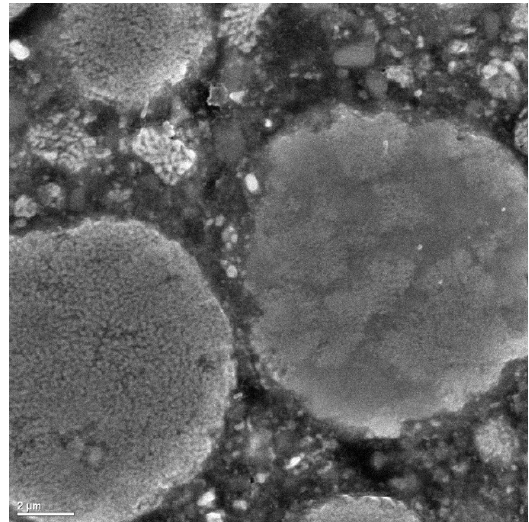
Figure 13. SEM micrograph of high-energy mechanically-alloyed Al 2 O 3 -Ni(Cr) nanostructured cermet particles for high pressure cold spray coatings development [57].